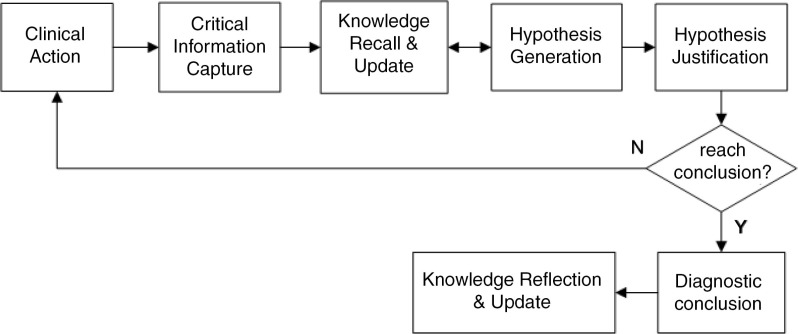
Learning flowchart.